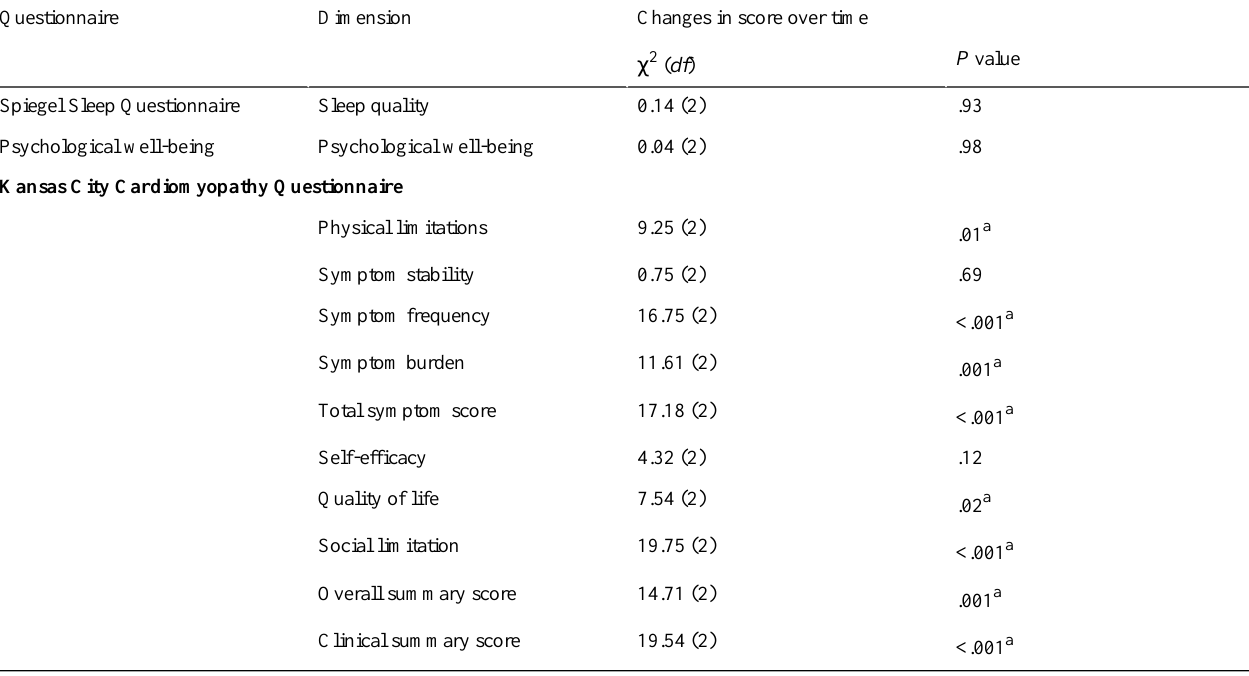
Table 3. Results of the Friedman test of the individual dimensions during 1